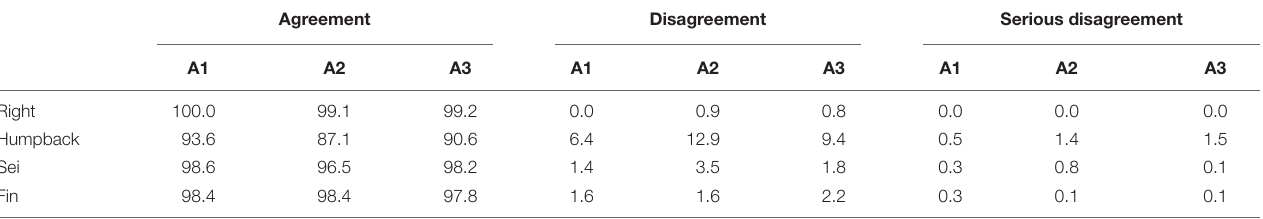
TABLE 5 | Within-analyst agreement, disagreement, and serious disagreement (%) for one experienced (A1) and two novice analysts (A2 and A3).